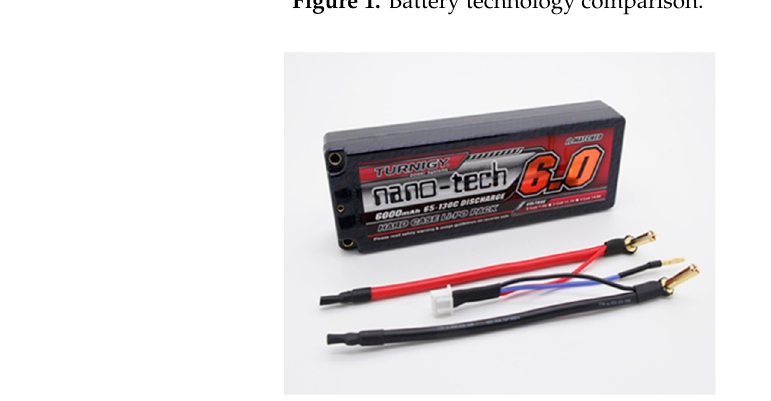
Figure 2. Basic battery module [20].